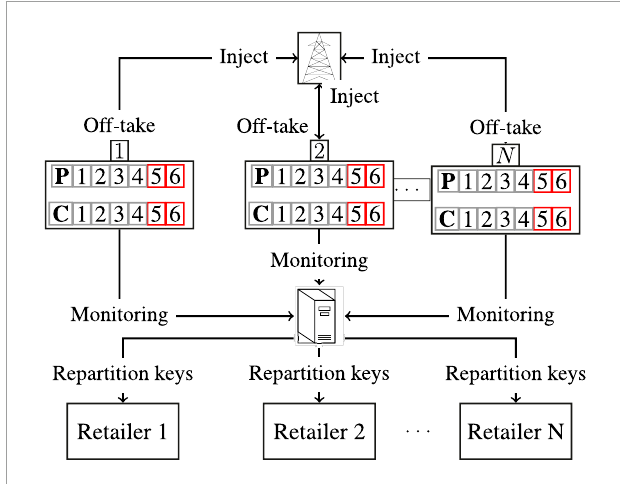
FIGURE 1 Illustration of a REC. Each member i ∈ { 1 ,…, N } is associated with a specific consumption meter (C) and a production meter (P). At each discrete time step t , these meters are incremented by the energy consumption and production of each member during the time interval] t , t + 1], respectively. These meters are monitored at the end of each metering period by an energy management system (EMS). The EMS can modulate the controllable assets. It also computes optimal repartition keys with the values monitored from all the meters of the REC members and send them to their respective retailers. Retailers periodically (e.g., monthly) compute the electricity bills of each REC members based on the repartition keys and sends them to their respective